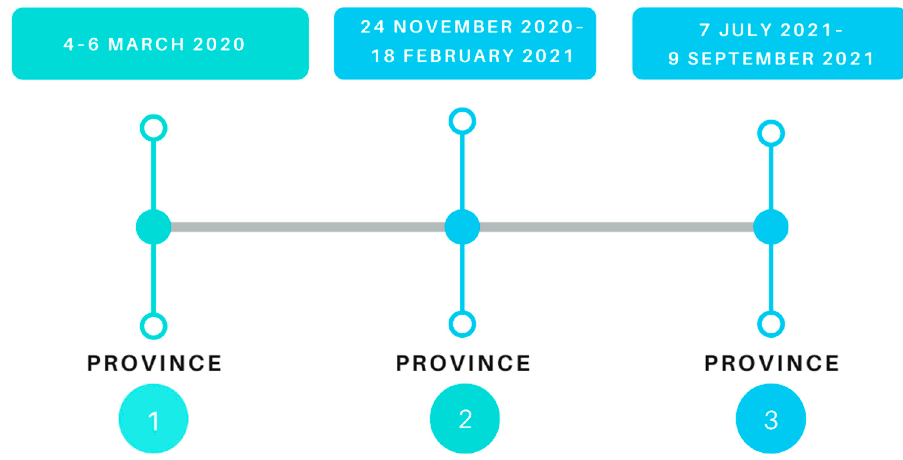
Figure 1. Timeline of data